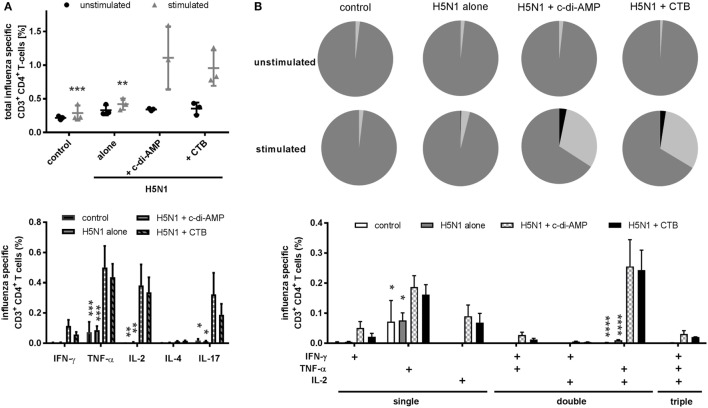
T cell quality. Groups of three BALB/c mice were immunized intranasally with PBS (control) or with two doses (21 days apart) of H5N1 virosomes (7.5 µg hemagglutination), alone or adjuvanted with cyclic di-adenosine monophosphate (c-di-AMP) (5 µg) or cholera toxin subunit B (CTB) (5 µg). At 21 days after the second immunization, spleen cells were harvested, restimulated with homologous H5N1 virosomes, intracellularly stained for Th cytokines (IFN-γ, IL-2, TNF-α, IL-4, and IL-17), and analyzed by flow cytometry. (A) CD4+ T cell producers. Upper panel: all CD4+ cells producing at least one of the measured cytokines were summed to quantify the frequency of influenza virus-specific Th cells. The mean ± SD is shown; each symbol represents one animal. Lower panel: the mean + SEM of all CD4+ cells producing at least the indicated cytokine is shown. The number of unstimulated cells was subtracted from the respective number of stimulated cells. (B) Multifunctional T cell activity. The pie charts show the proportion of single (dark gray), double (light gray), and triple (black) cytokine producers; the bar chart shows the frequency (mean + SEM) of single, double, and triple Th1 cytokine-producing CD4+ cells. The number of unstimulated cells was subtracted from the respective number of stimulated cells. Statistically significant differences were measured by two-way ANOVA with Tukey’s post hoc test; differences from the c-di-AMP group are shown by asterisks (*p < 0.05, **p < 0.01, ***p < 0.001, ****p < 0.0001).